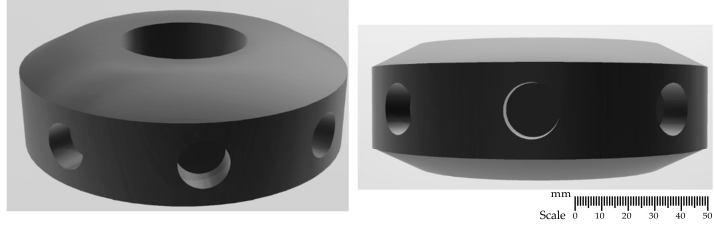
Figure 2. A 3D model—impeller with eight holes—variant B8.